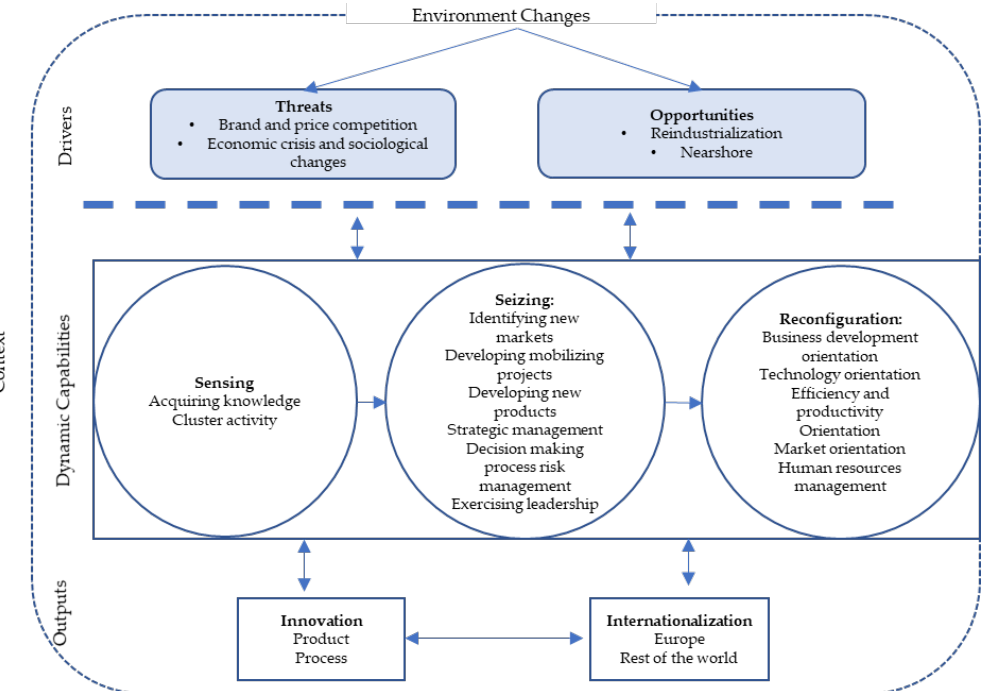
Figure 2. The building of a theoretical model.